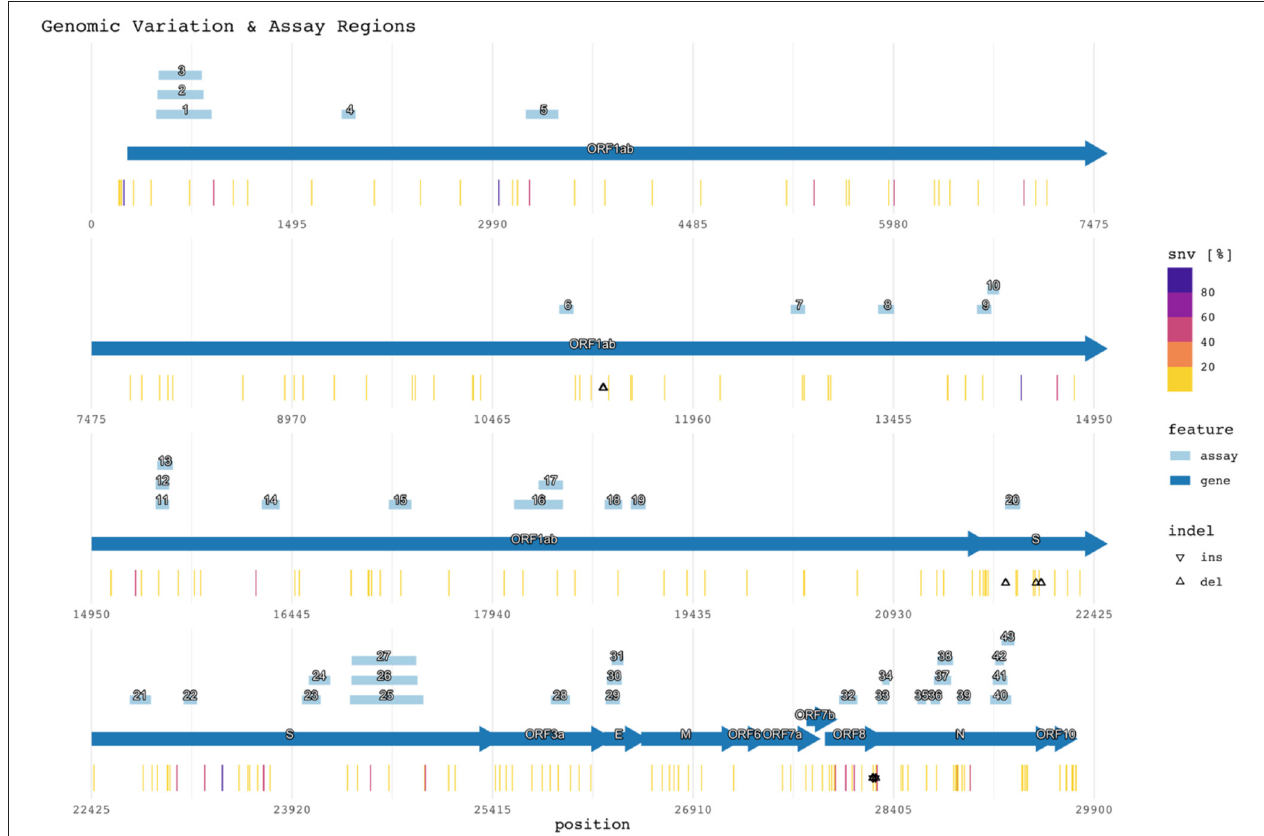
FIGURE 2 | Genomic variation and assay regions. The numbered rectangles and labeled arrows indicate PCR assay and gene regions respectively. Heat values indicate the percentage of SNVs observed at the reference location across all subjects. Percentages for both SNVs and indels are compiled in Supplementary Table 4